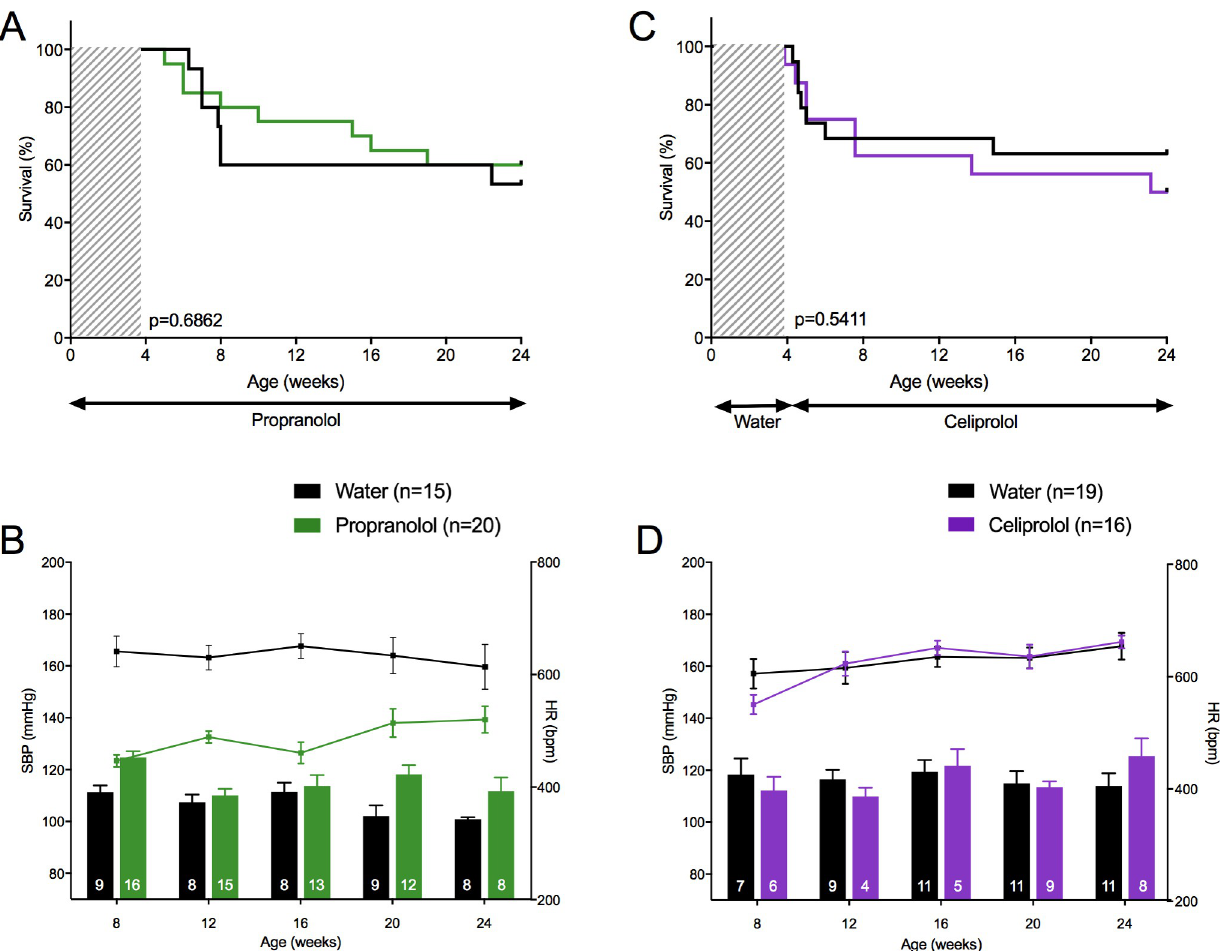
Fig 6. Therapeutic challenges: hemodynamic parameters and survival curves of β -blockers. The upper panels represent the survival curves on either active treatment or water. The lower panels represent SBP (lower bars: left scale) and HR (upper lines: right scale), measured between 8 and 24 weeks. Data are expressed as mean ± SEM. Numbers within the bars indicate the number of living mice studied at each time of measurement. A-B Comparison between propranolol and water. A Kaplan-Meier Survival curve for comparing Col3a1 +/G182R treated with propranolol (n = 20) to Col3a1 +/G182R treated with water (n = 15). Insignificant difference is calculated using Log-Rank (Mantel-Cox) analysis (p = 0.6862). B Despite a significant decrease in HR (student t-test, p < 0.05 at each time except 24 weeks), there was no decrease in SBP on propranolol that was even higher than in the untreated group (student t-test, p < 0.05 at 8 and 20 weeks). C-D Comparison between celiprolol and water. C Kaplan-Meier Survival curve for comparing Col3a1 +/G182R treated with celiprolol (n = 16) to Col3a1 +/G182R treated with water (n = 19). Insignificant difference is calculated using Log-Rank (Mantel-Cox) analysis (p = 0.5411). D SBP and HR were not changed by celiprolol (student t-test, p > 0.05 throughout the follow-up period).